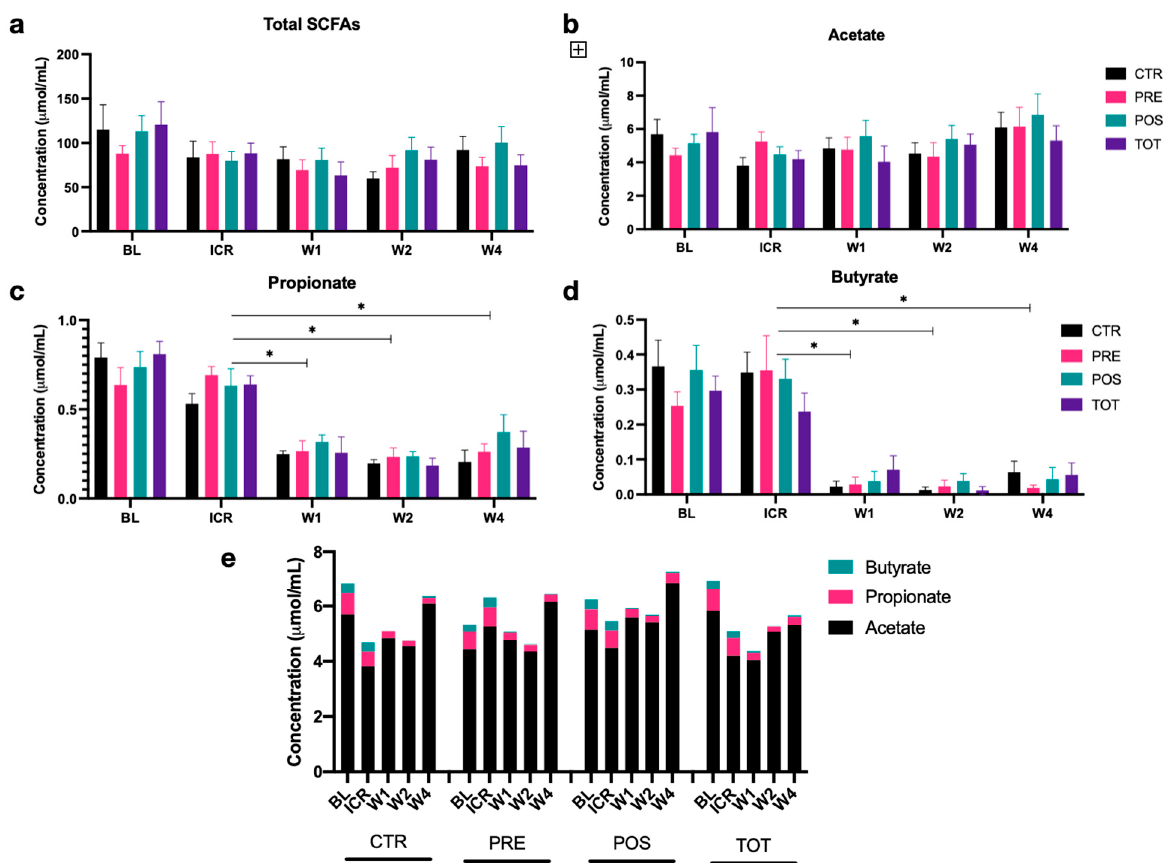
Figure 4. Concentrations of fecal short-chain fatty acids (SCFAs) from BL to W4 by intervention group. Column graphs represent median +/ − SEM. ( a ) Total SCFAs. ( b ) Acetate. ( c ) Propionate. ( d ) Butyrate. ( e ) Proportion of SCFAs. * represents p < 0.05.